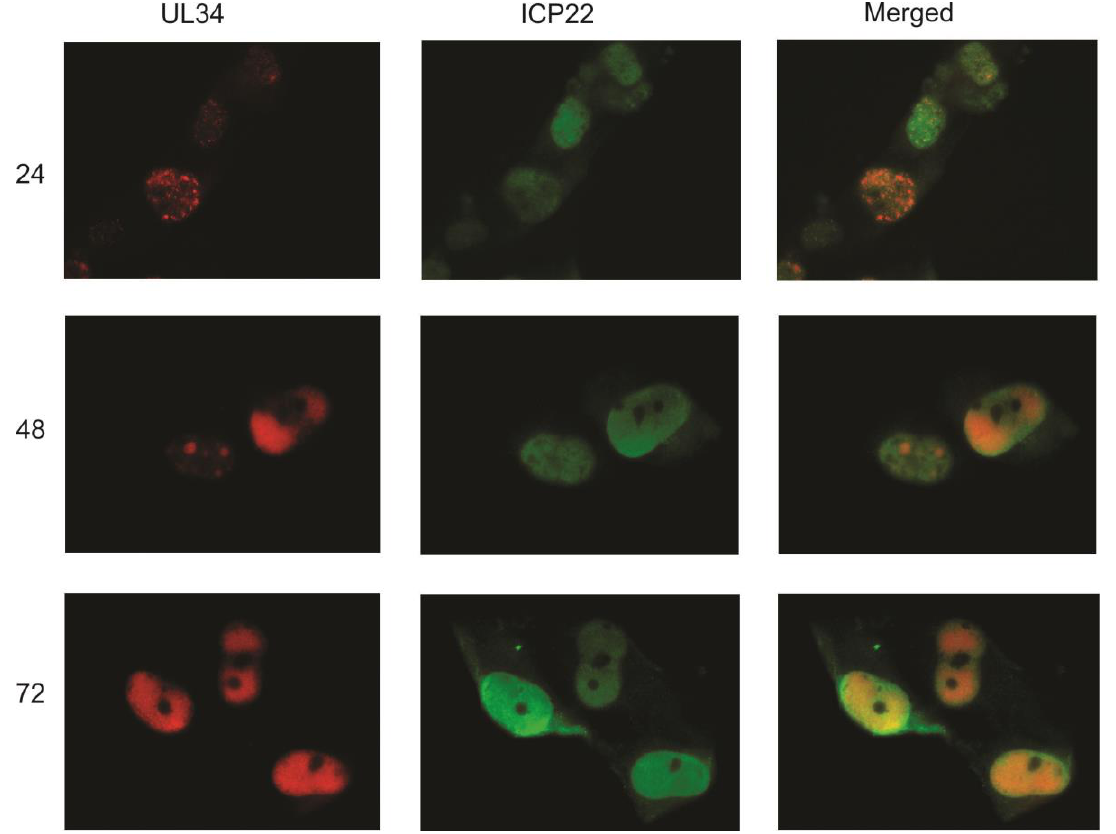
Figure 4. Indirect immunofluorescence was performed on primary human fibroblasts infected with HCMV strain Towne at 24, 48, and 72 hpi using antibodies to UL34 and to ICP22. UL34 staining is red, ICP22 staining is green; the merged column is a combination of the red and green